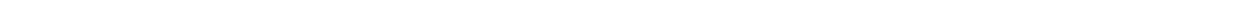
Fig. 5 G-CSF enhances the cytotoxicity of AraC+CHK1i on AML in vivo. a Treatment regimen for AraC, CHK1i, and G-CSF with primary AML samples and normal hematopoietic cells, in vivo. b Percentage of human cells in the bone marrow of mice transplanted with four primary AML samples 1 week post treatment. The treatment started at HE (gray area). Each dot represents an individual mouse. AML5 UT n = 5; A+C n = 4; A+C+G n = 3; AML6 UT n = 5; A +C n = 6; A+C+G n = 5; AML7 UT n = 4; A+C n = 4; A+C+G n = 4; AML8 UT n = 3; A+C n = 4; A+C+G n = 3. Number of total mice = 50. c Percentage of human cells in the bone marrow of AML7-transplanted mice 1 week post treatment. d Remaining leukemic cells in the bone marrow of AML7-transplanted mice 1 week post treatment shown by hematoxilin & eosin (H&E, left panel) and immuno fl uorescence (right panel). Green cells are human CD45 + , red cells are Ki67 + , and nuclei are labelled blue. Scale bar is 100 micron for all images. Lower graph represents the ratio of cycling Ki67 + CD45 + cells. e L-LTC-IC assay on hCD45 + cells pooled from AML7-injected mice 1 week post treatment. Cells were kept in vitro for 2 weeks in methylcellulose in a LDA assay. Linear regression with 95% con fi dence bands, ( p value = 9.6 − 11 . A+C n = 3; A+C+G n = 3). f Secondary transplantation of hCD45 + cells, pooled from AML8-injected mice 1 week post treatment. Each dot represents an individual mouse (A+C n = 3; A+C+G n = 3). g Percentage of human cells in the bone marrow of hBM-transplanted mice 1 week and eight weeks post treatment (UT n = 4; G n = 4). * p < 0.05 and ns = non-signi fi